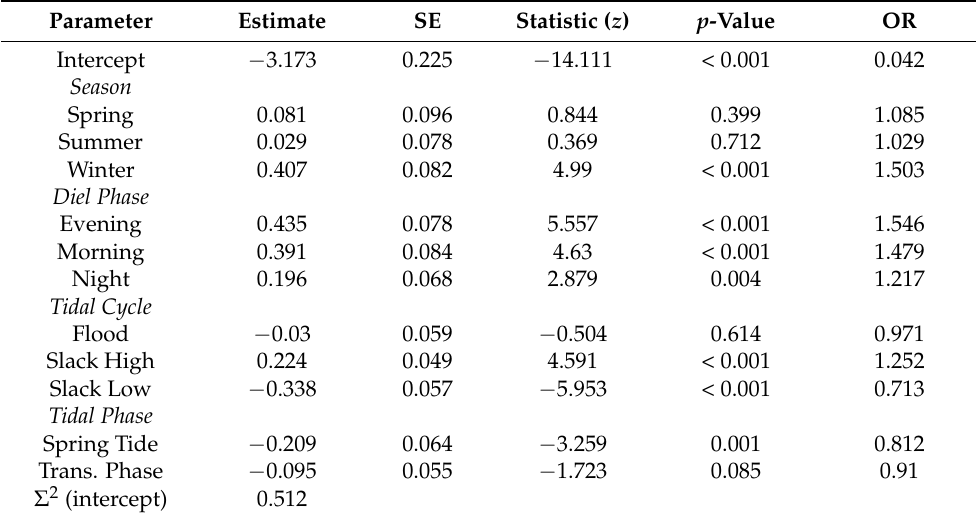
Table 2. Final model for Moneypoint ( n = 42,954 minICIs of which 3155 classified as foraging. Recorded by 13 different C-POD units). Estimates with standard errors (SE) and odds ratios (OR) of the variables included in the model. Σ 2 is the variance of the intercept due to variability between C-PODs (C-POD ID as random factor).